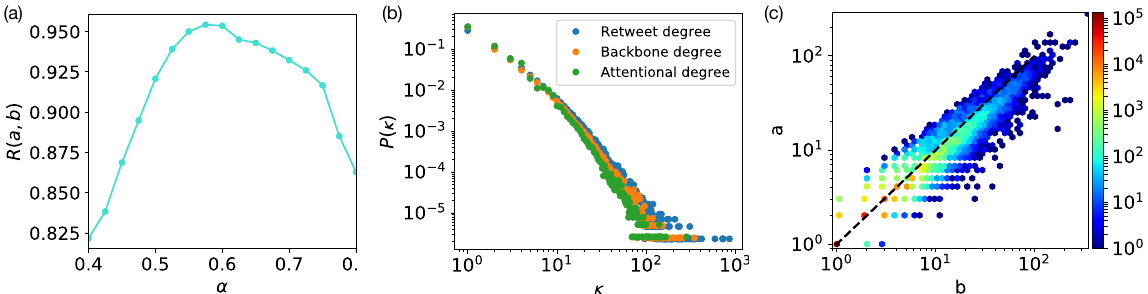
Figure A1. Distributions and correlations of degrees measured in the backbone networks or as attentional (c) degrees. ( a ) R ( a , b ) Pearson correlation values between the a attentional and b backbone degrees as the function of the α disparity filter parameter. ( b ) Distributions of retweet, backbone, and attentional degrees of users. ( c ) Correlations between the a attentional and b backbone degrees computes with the optimal disparity filter value α =